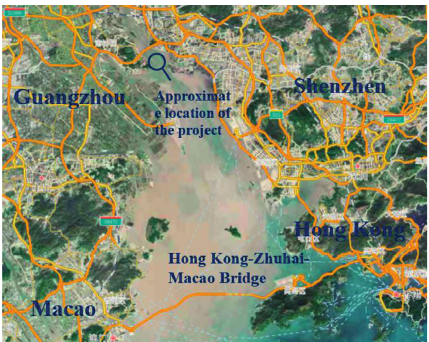
Figure 1: Location of the foundation pit of Nansha International Cruise Terminal